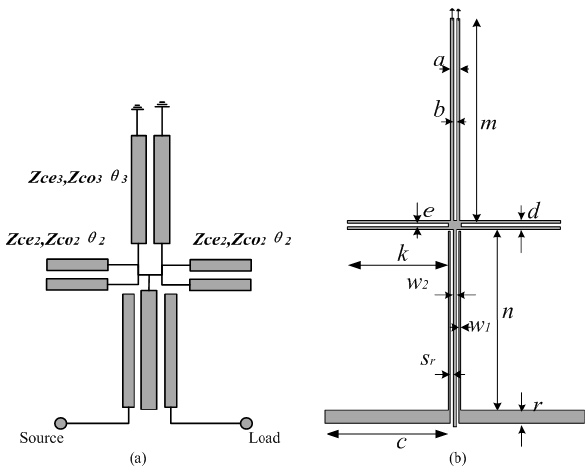
Figure 6. Simulated frequency responses of the proposed CLCSR filter with varied parameters ( a ) θ 2 and ( b ) θ 3 .